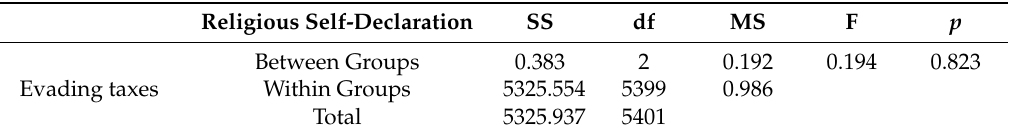
Table A8. Evading taxes among religious self-declaration.